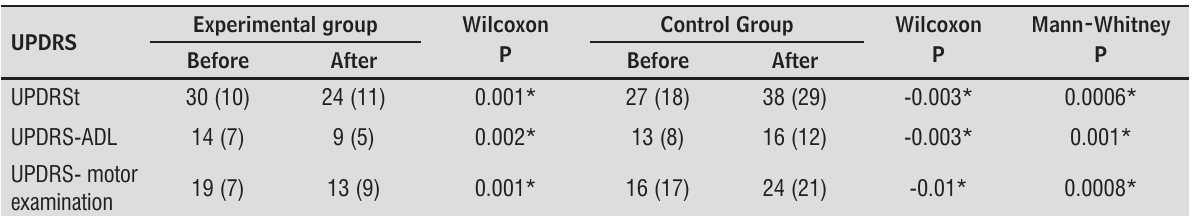
Table 3 - Expresses the median (interquartile range) of the UPDRS scores before and after a home-based program of self-supervised therapeutic exercises, according to whether or not they use individual guidance and